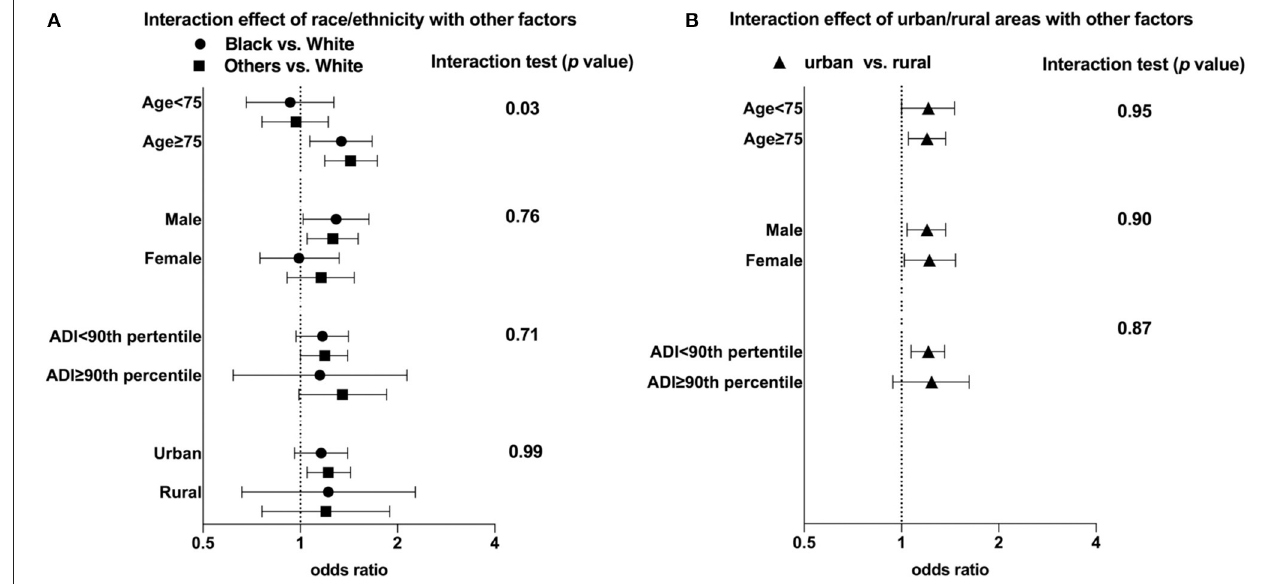
FIGURE 2 | Interactions of race/ethnicity and urban/rural residence with age, sex, and area of deprivation index. ADI, Area of Deprivation Index. In addition to the listed factors, the model was also adjusted for CHA 2 DS 2 -VAS c score, valvular disease, geographic region (Northeast, South, Midwest, and West), Medicaid enrollment, low income subsidy and end stage renal